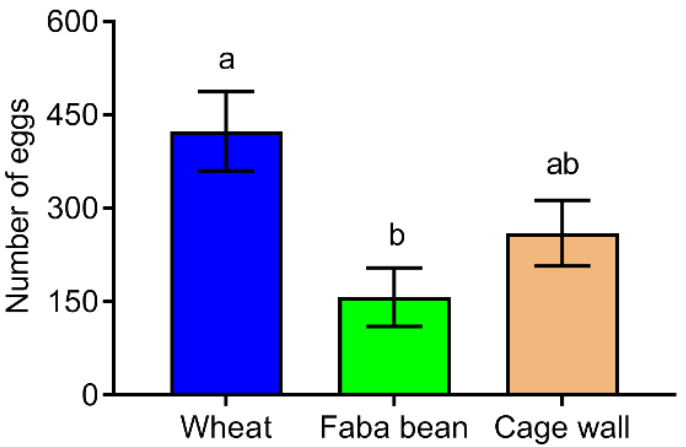
Figure 4. The oviposition preference of S. frugiperda for wheat and faba bean plants in cage tests. All data are presented as the mean ± standard error (SE). Different letters on the top of standard error bars indicate significant differences among groups (Tukey’s HSD tests, p < 0.05).